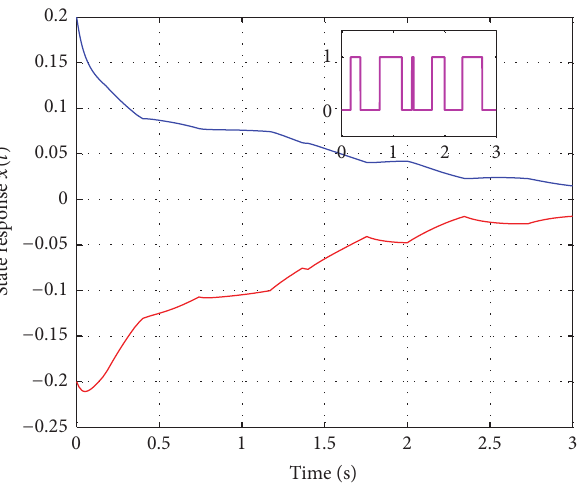
Figure 4: Time history of 𝑥 𝑇 (𝑡)𝑊𝑥(𝑡) .